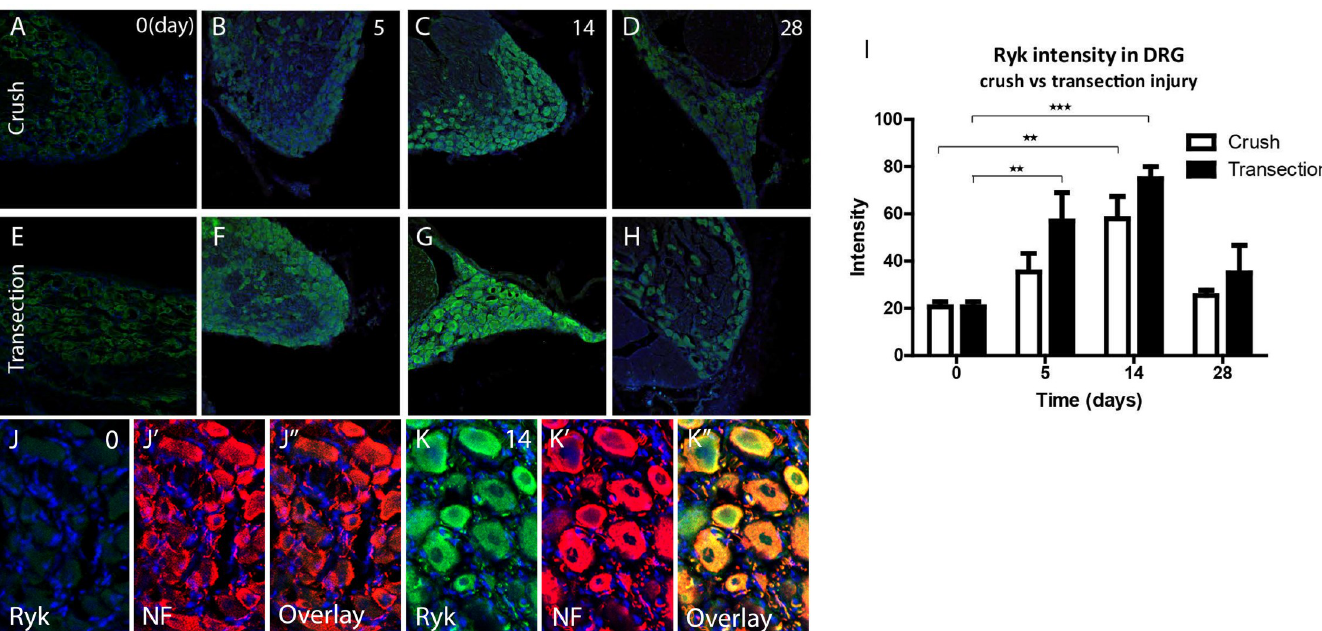
Fig 9. Ryk protein expression is increased in axotomized DRG neurons. A-H, Immunohistochemical staining of Ryk (green) in L5 DRG following sciatic nerve crush (top row) or transection (bottom row) ranging from control (0 day) to 28 days p.i. (right column). Ryk staining intensity is low in control DRG neurons (A, E). Ryk staining intensity increased over time, and peaks at 14d p.i. (C, G) and returns towards baseline at 28d p.i. (D, H). I, Quantitative analysis of Ryk expression in DRG following sciatic nerve lesion ( � p < 0.05, �� p < 0.01, ��� p < 0.001, error bars represent SEM). J, K, High magnification of DRG tissue sections. Immunohistochemistry for RYK (green) and NF (red) shows that control neurons (J) express very low amounts of RYK (J’). The increase in RYK expression at 14 days following nerve transection (K) is mainly due to an increase in neuronal (NF, K’) expression of RYK (Overlays in J” and K”).